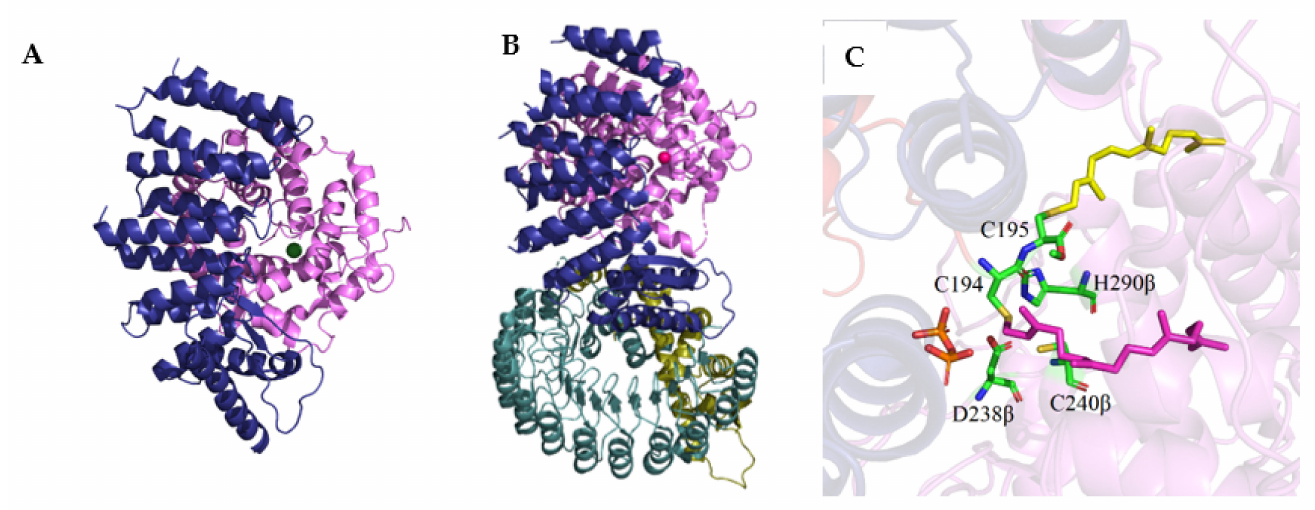
Figure 8. Structure of GGTase-III ( A ) (PDB: 6J6X), GGTase-III-FBXL2-SKP1 complex ( B ) (PDB: 6O60), and complex of GGTase-III, farnesyl-Ykt6 (C-terminal methylated), and GGPP ( C ) (PDB: 6J7F). (Created in the PyMOL Molecular Graphics System, Version 2.5.2 Schrödinger,